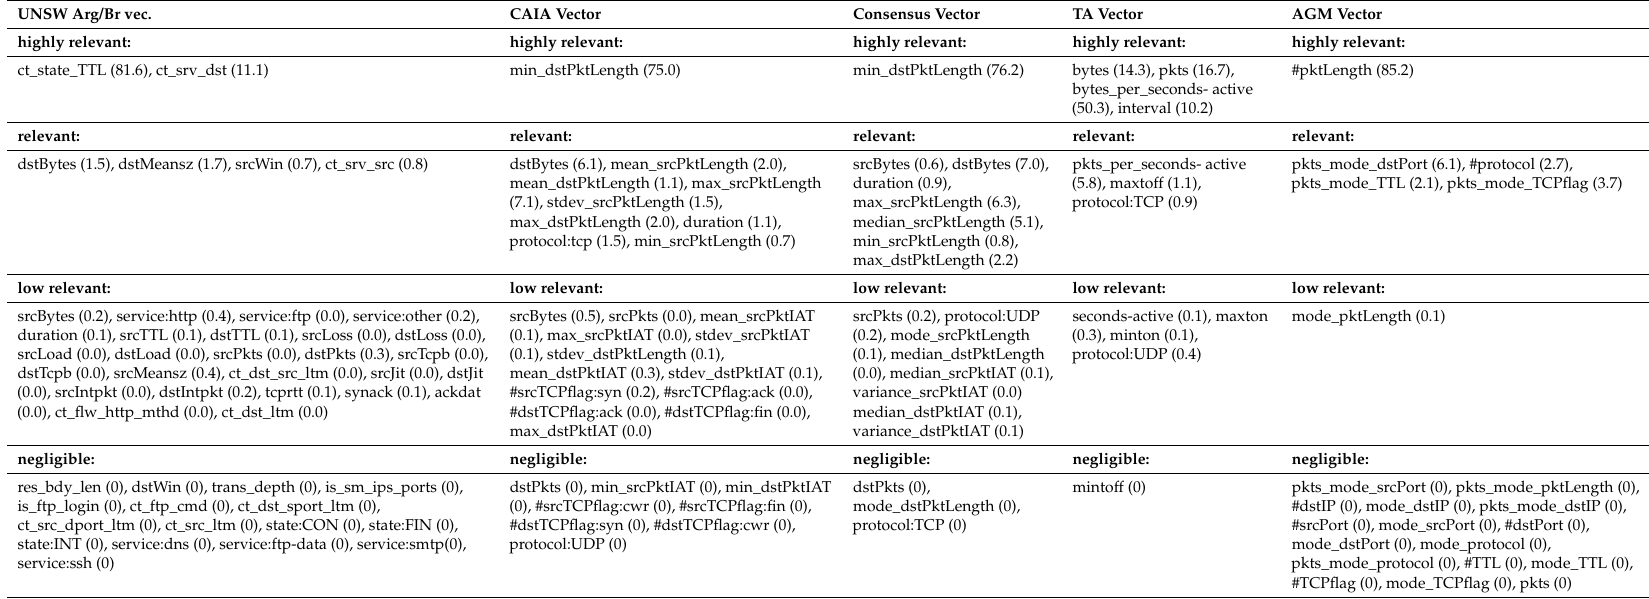
Table 6. Feature selection